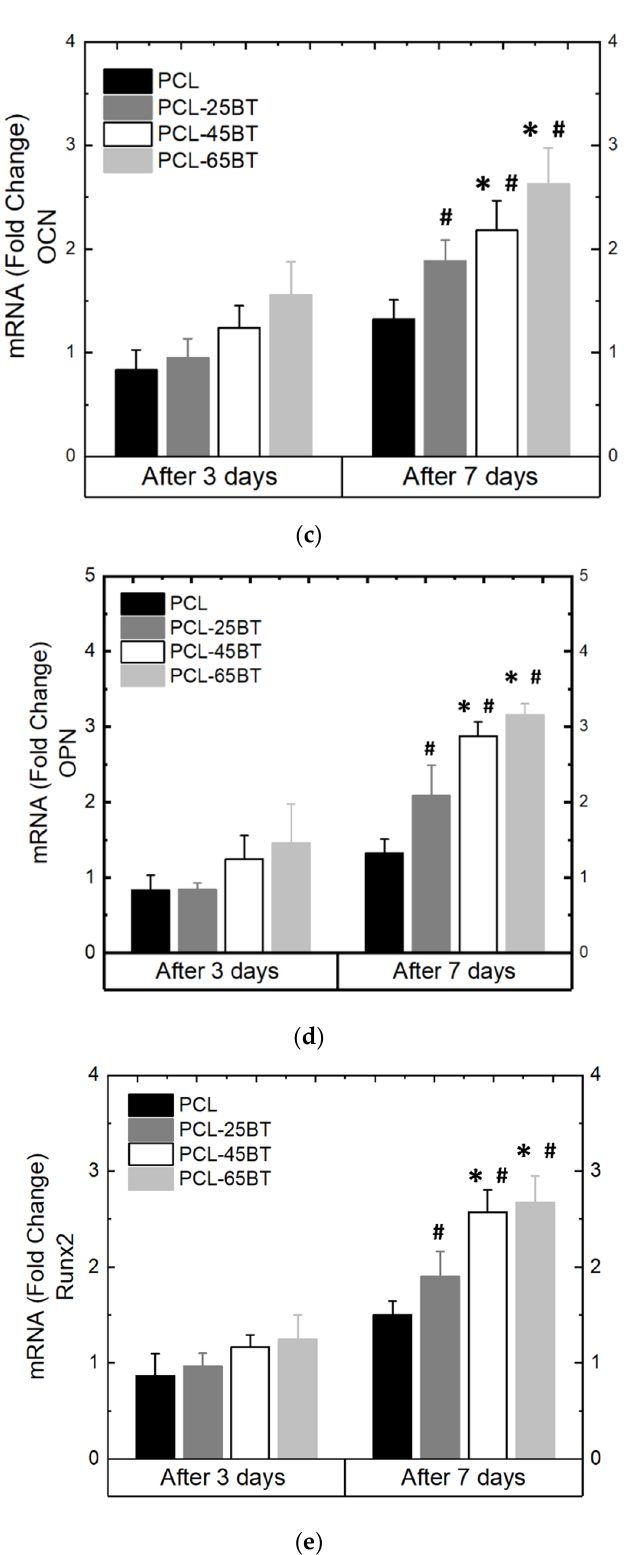
Figure 13. Differentiation properties of MC3T3 cells as cultured on the piezoelectric scaffolds. The following osteogenic gene markers were quantified: ( a ) Col 1 ( b ) ALP ( c ) OCN, ( d ) OPN, and (e) Runx 2 and expressed as fold change with respect to the control; 3 MHz US was used per the routine for all the differentiation assays. * means statistically significant ( p < 0.05) with respect to the control (PCL) in the same group. # means statistically significant ( p < 0.05) with respect to the fold changes of the same specimen in the “after 3 days”